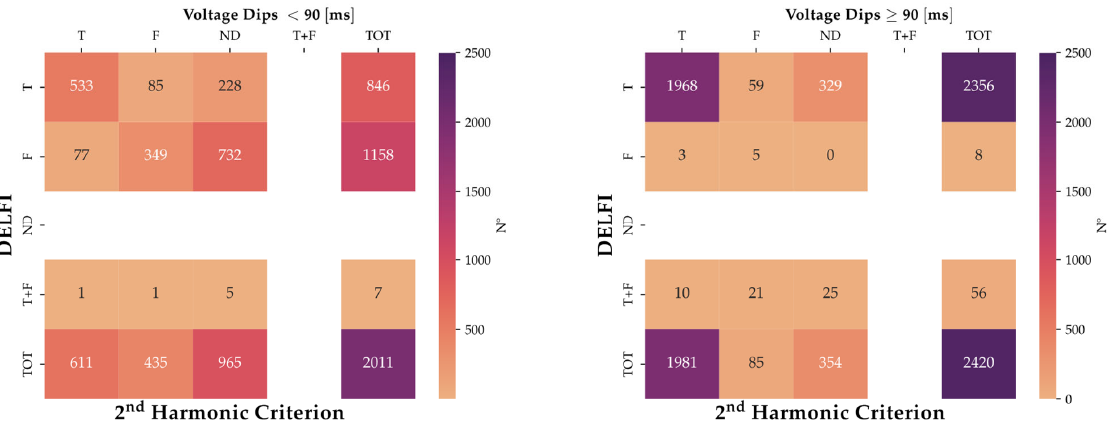
Figure 17. Validity assessment: 2nd Harmonic and DELFI outcomes with respect to voltage durations for IN Subset.